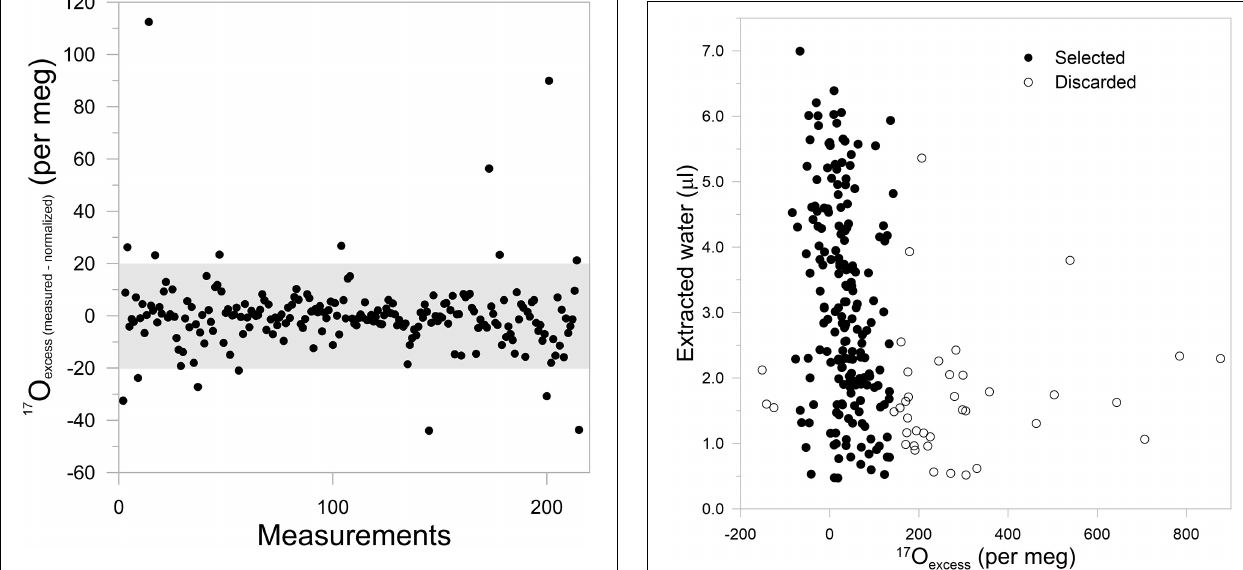
FIGURE 6 | Selection of values using the criteria given in section “Speleothem Fluid Inclusion 17Oexcess Values and Data Selection.” 17 O excess values versus extarcted water amount (if available). Discarded values are shown as open circles.